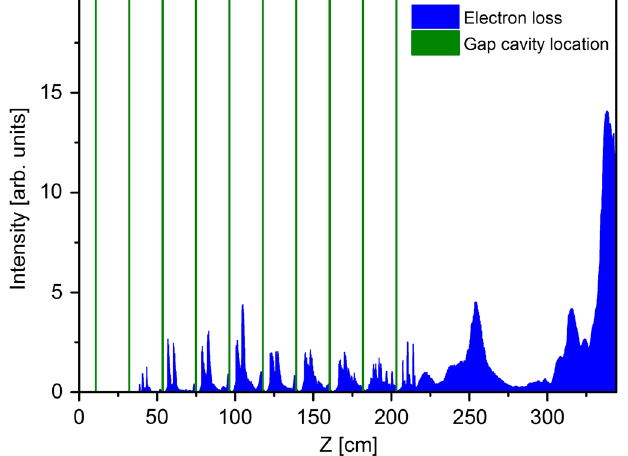
FIG. 9. Calculated time-integrated electronic losses occurring throughout the transmission line. The green lines represent the center of the accelerating gap of each cavity.